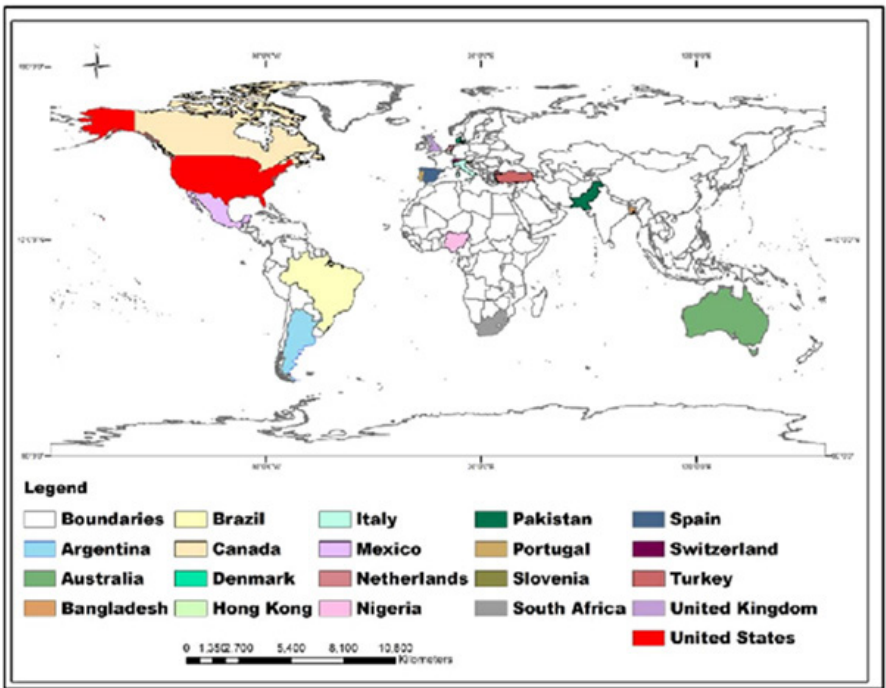
Figure1. Spatial distribution of countries from which information on occupational hazards and exposures among the veterinary profession were retrieved.